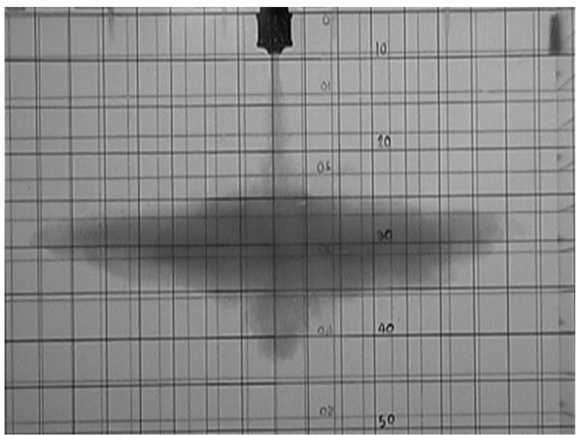
Figure 3. Typical image extracted from the videotape of an experiment of a positively buoyant jet in a linearly density-stratified ambient. Note the double grid in the front and rear Lucite panels of the dispersion tank. The jet plenum edge with nozzle is shown at the top of the